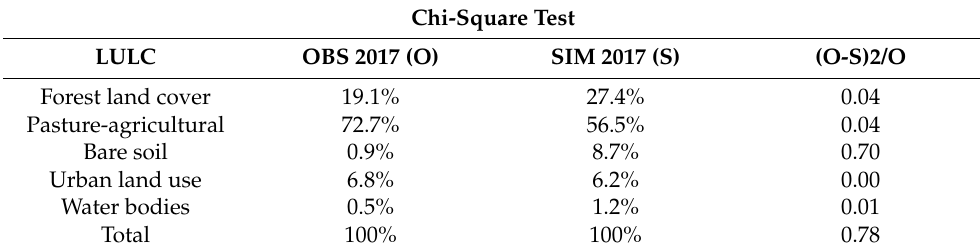
Table 3. Validation of land use and cover, 2017 observed and simulated 1 .